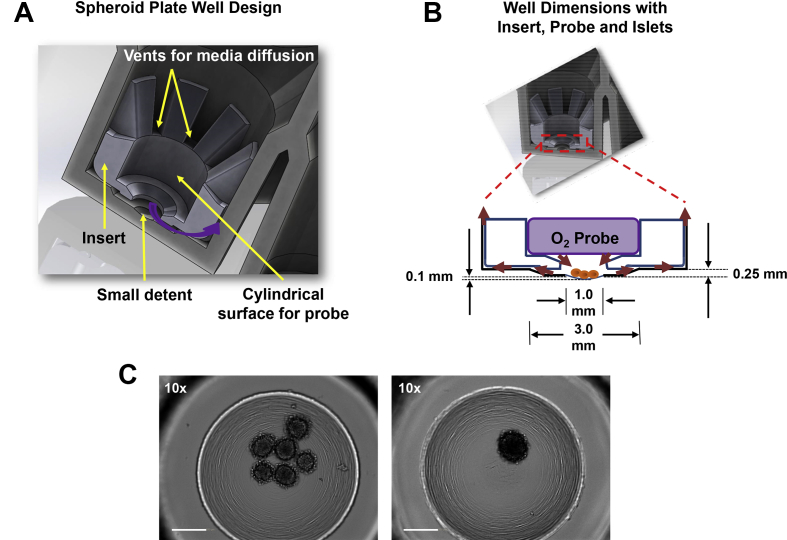
Design of the XF96 spheroid plate for high-throughput islet respirometry. (A) Cross-sectional diagram depicting the design of a single well of the new XF96 spheroid plate. Yellow arrows highlight the small detent for islets, configuration of the well insert, space for the oxygen probe and vents for media diffusion. Purple arrow indicates media flux between the small measurement chamber containing the islet and the rest of the well. (B) Dimensions of the XF96 spheroid well, showing the small volume measurement chamber containing islets (small brown spheres) created when the oxygen probe sits in the well insert. (C) Operetta brightfield images of 6 mouse islets or an individual mouse islet in a well of the XF96 spheroid plate after a Seahorse respirometry experiment. Images captured at 10× magnification. Scale bars = 200 μm.